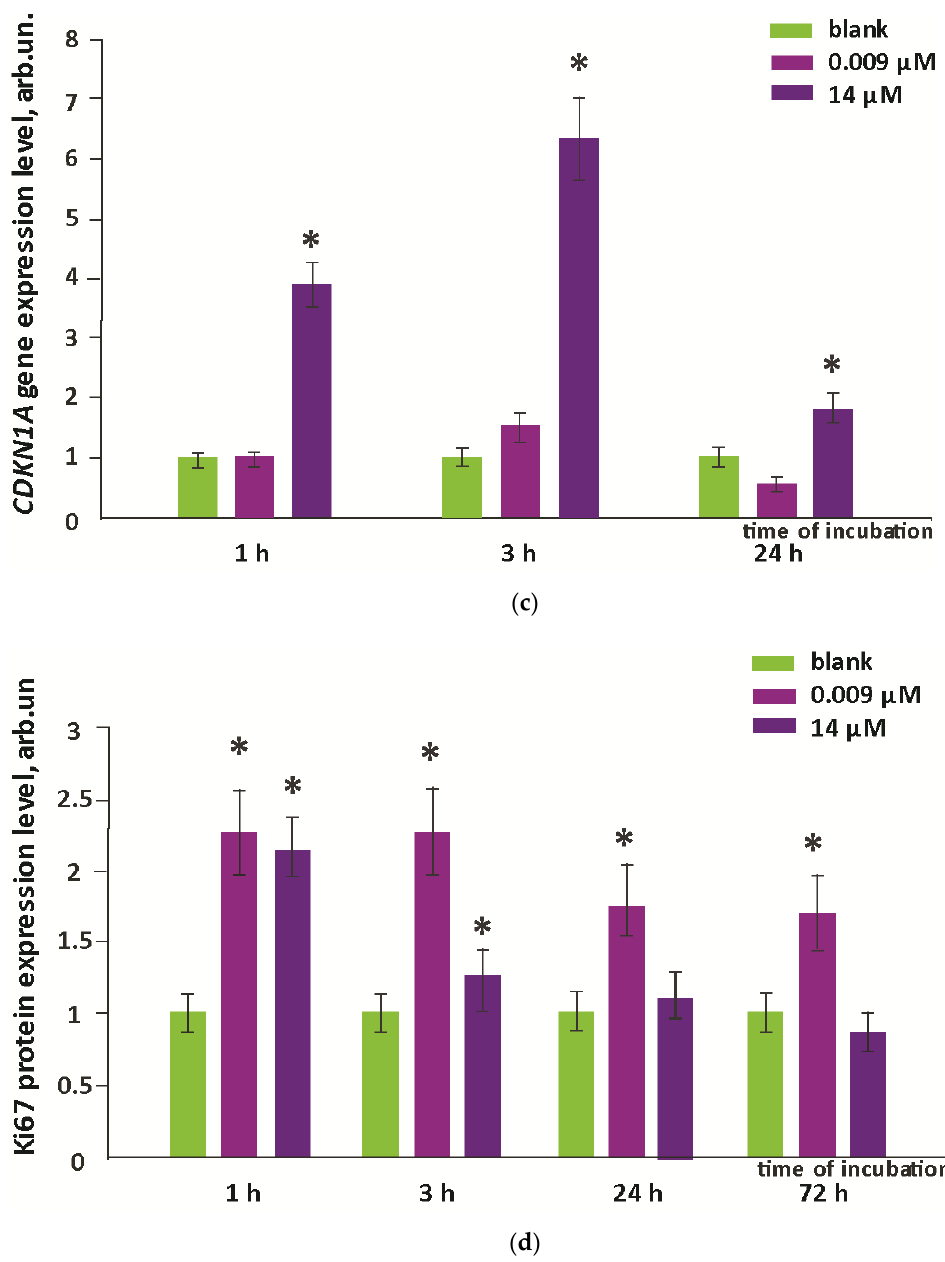
Figure 9. Expression of CCND1 ( a ), CDKN2 ( b ), and CDKN1A ( c ) genes in HELF cells. The number of RNA genes is the average from three experiments related to the control value. TBP was used as an internal standard gene. The level of Ki-67 protein ( d ) in HELFs treated with F1 relative to control values (cells cultured without the fullerene) is shown. Significant differences with the control by the Mann − Whitney test ( p < 0.01) are denoted by “*”.